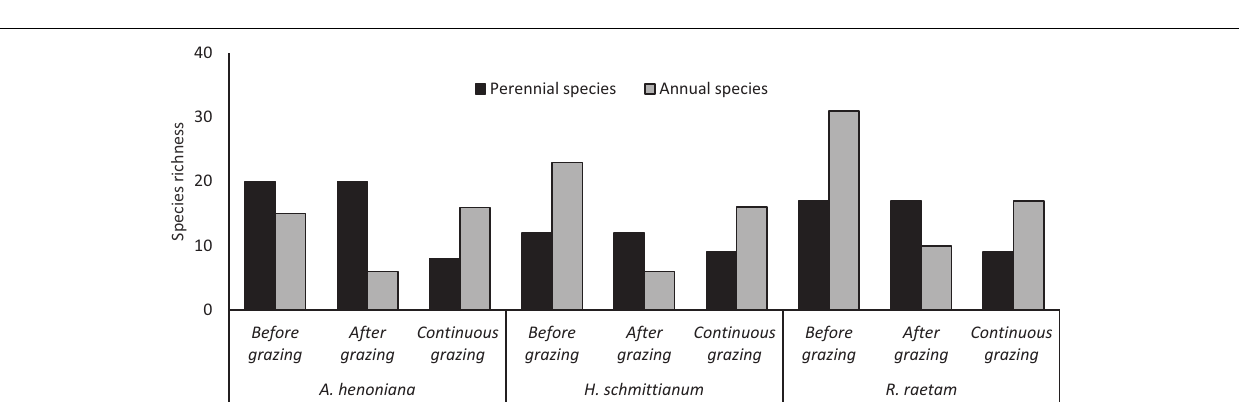
FIGURE 6 | Species richness of perennial and annual species in 2 years protected plant communities ( A. henoniana, H. schmittianum, and R. raetam ) sites before and after subjecting to 1 week of intense grazing compared to continuous grazing sites in Tataouine, Tunisia.